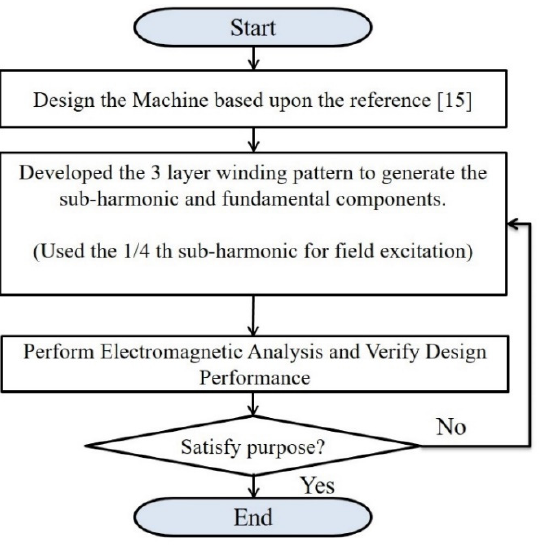
Figure 4. Flowchart of the design process.